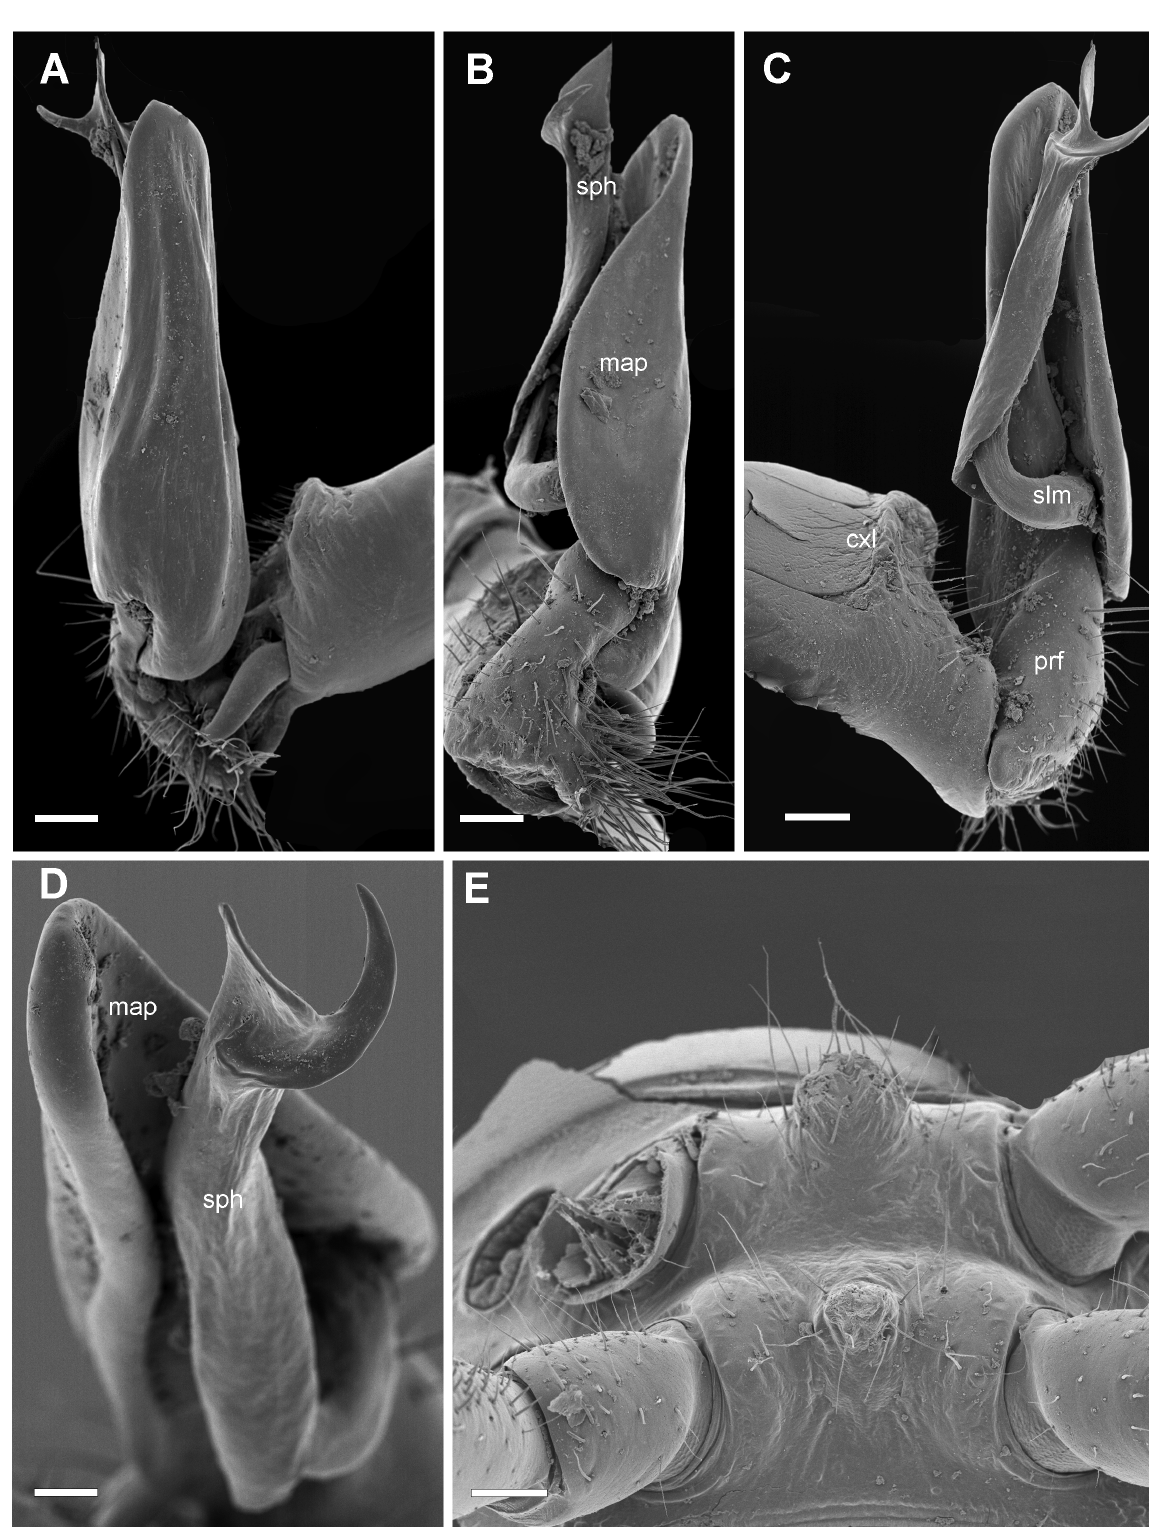
Fig. 35. Eviulisoma biquintum sp. nov., holotype. A–D . Right gonopod. A. Mesal view. B. Ventral view. C. Lateral view. D. Acropodite, subapical view. E . Sternum 5. Abbreviations: cxl = coxal lobe; map = mesal acropodital process; prf = prefemoral part; slm = solenomere; sph = solenophore. Scale bars: A–C, E = 0.1 mm; D = 0.05